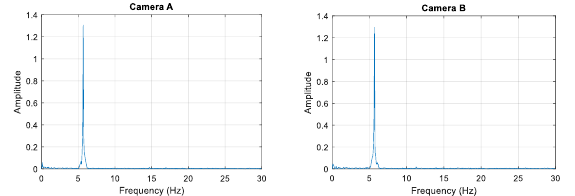
Figure 11. Frequency analysis of measured vibration after noise removal